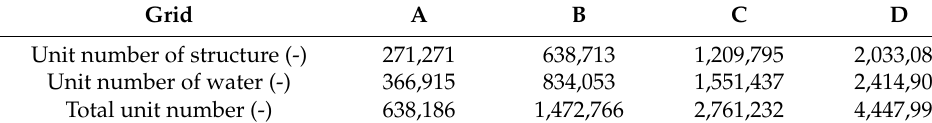
Table 1. Grid parameters of fluid structure coupling modal analysis of runner.